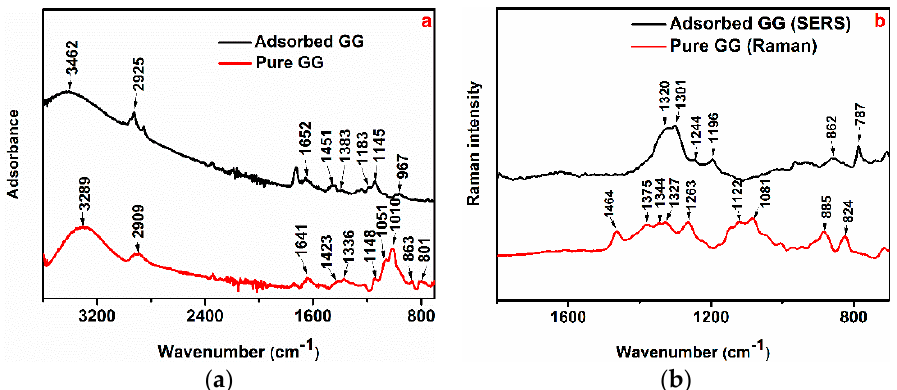
Figure 6. FTIR ( a ) and Raman ( b ) spectra of native Guar gum and surface-adsorbed Guar gum in the Figure 6. FTIR (a) and Raman (b) spectra of native Guar gum and surface-adsorbed Guar gum in the presence of the optimum concentration of GG (i.e., 0.4 g / presence of the optimum concentration of GG (i.e., 0.4 g/L).